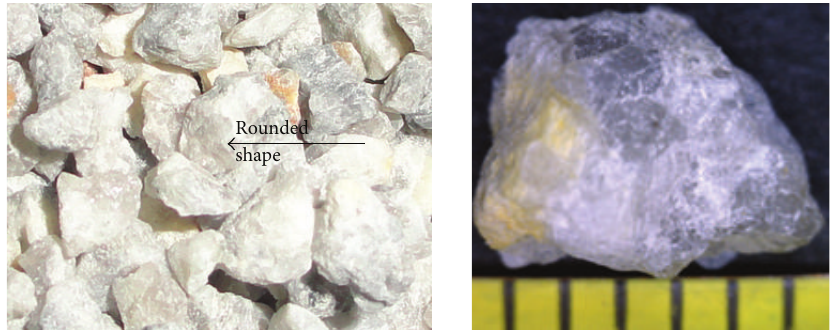
Figure 15: Shape of manufactured sand particle (2.36 mm retained).